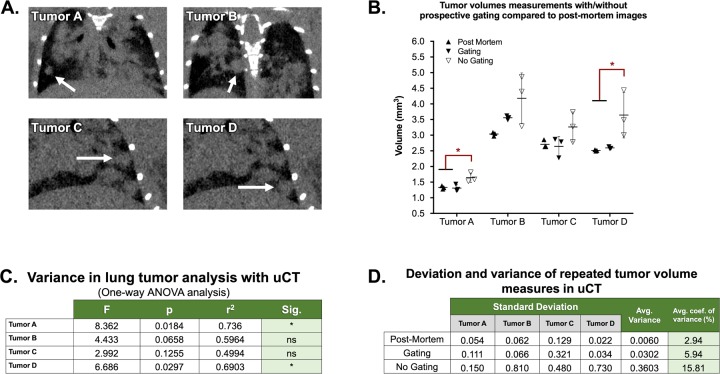
Respiratory gating improved the accuracy and precision of tumor volume measurements in the lung.Volumes were calculated for a collection of tumors (A) in 3 positions per condition, including a non-gated image, a gated-image, and an image acquired post-mortem (standard). When accounting for variance, volumes from non-gated images were significantly different from post-mortem standards in half of cases, while gated image volumes did not differ significantly (B; *P<0.05, ANOVA). The resulting ANOVA table describes the deviation and difference in means between acquisition condition per tumor (C). Coefficients of variation were calculated for each condition and averaged for each acquisition type (D).